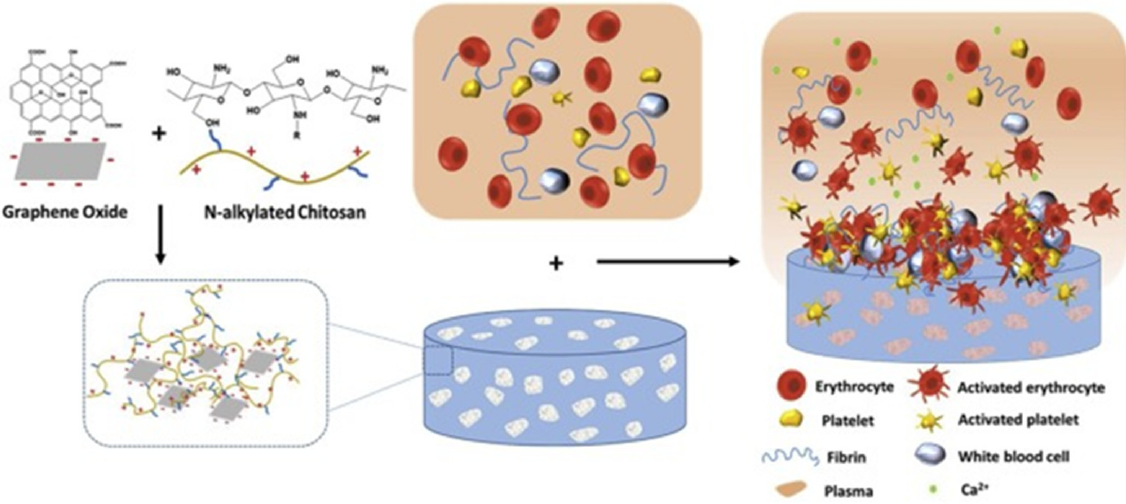
Figure 6. Schematic illustration of alkylated chitosan/GO hemostasis process [53].